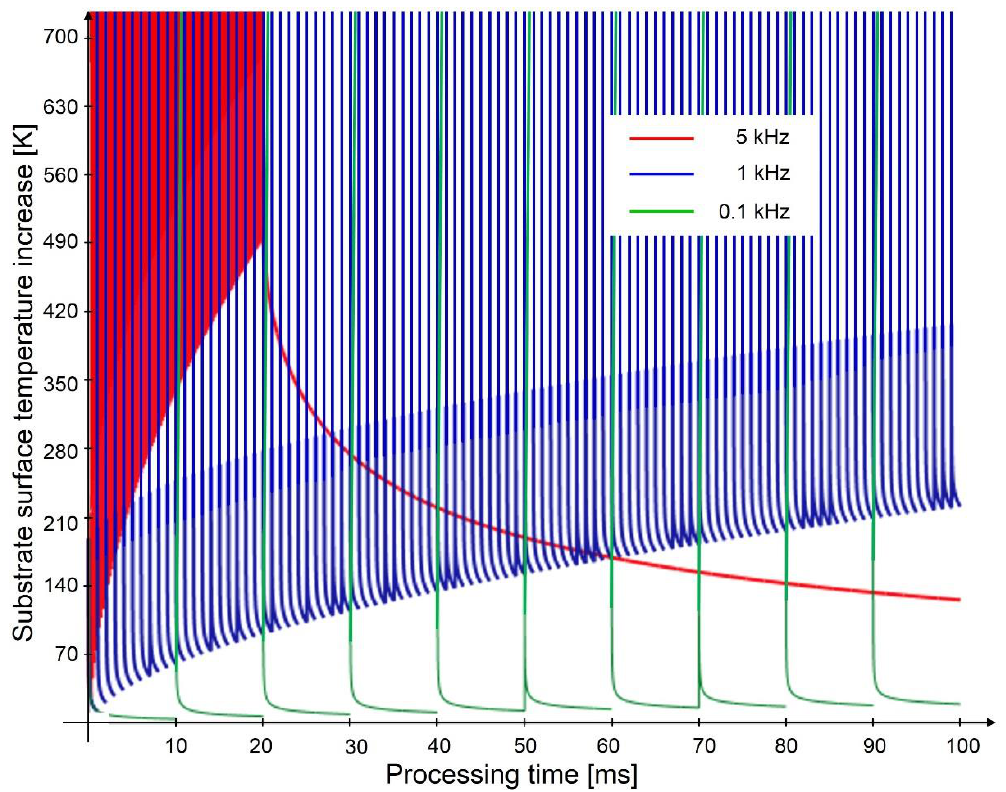
Figure 6. Calculation of the heating of a 1D volume of aluminum using a 10 ns laser pulse with a fluence of 3.2 J∙cm −2 and different pulse repetition rates of 0.1, 1, and 5 kHz.